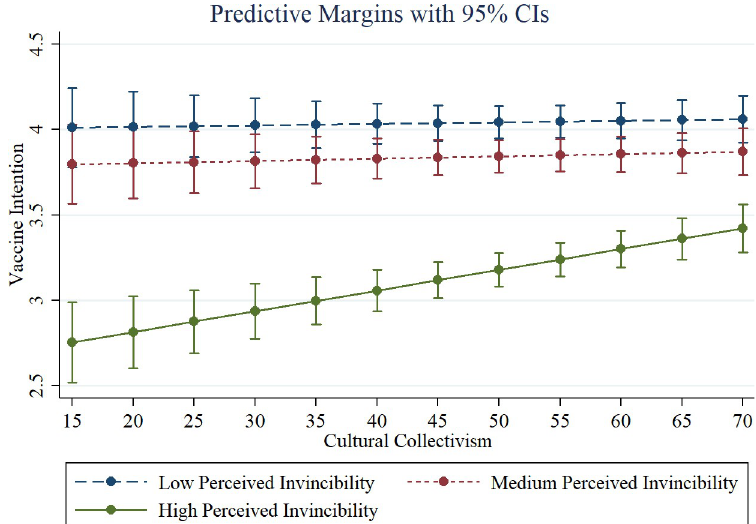
Fig 2. Predicted vaccine intention by perceived invincibility and cultural collectivism. Fig 2 uses linear mixed methods results from Table 2 Column (2).